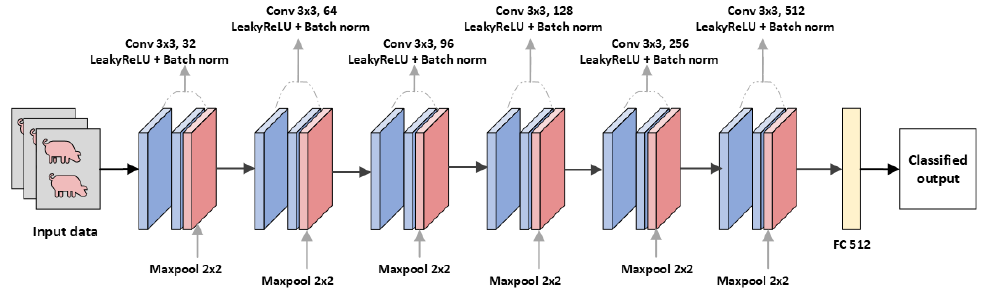
Figure 1. CNN-LeakyReLU: Convolution neural network with LeakyReLU and batch